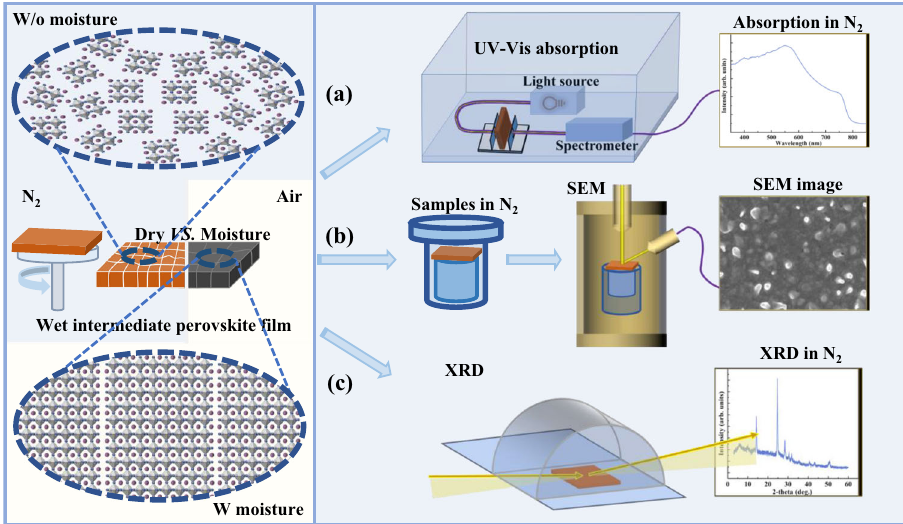
Fig.1|SchematicdiagramoftherepresentativeN2-protectedcharacterization techniques.a UV-visabsorption, b SEM,and c XRD.Allthesamplepreparationand sealing are carried out in the N 2 - fi lled glovebox. The UV-vis absorption measure- ment is carried out in the N 2 - fi lled glovebox. The as-prepared intermediate